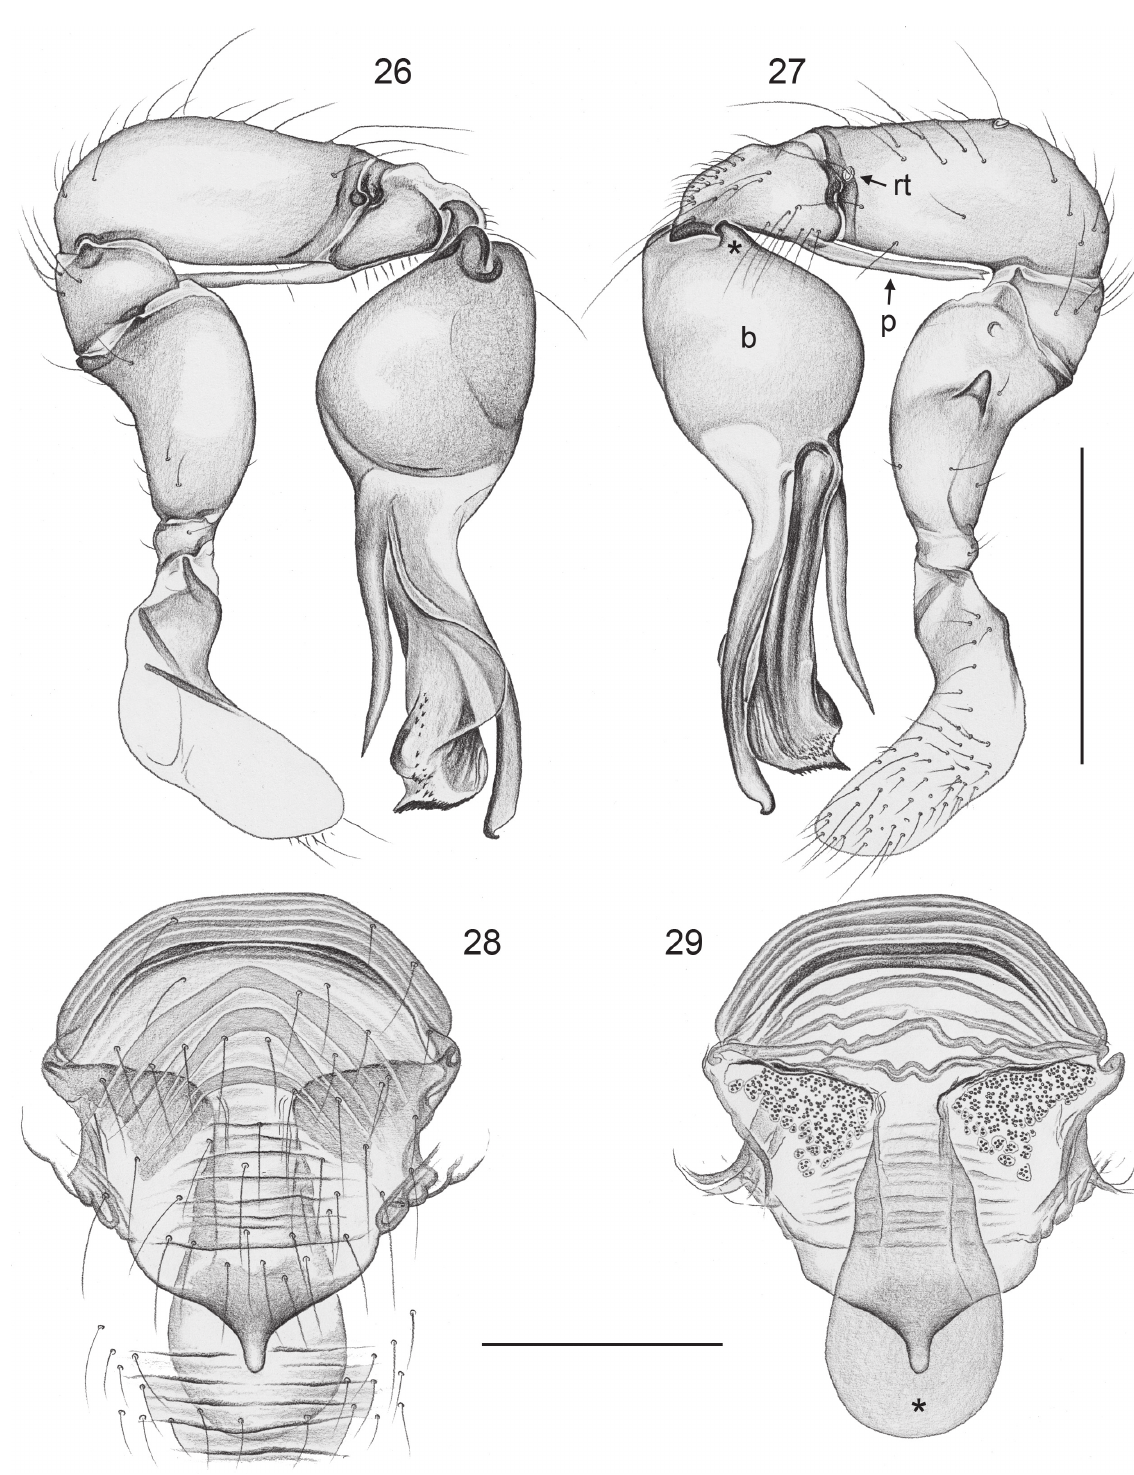
Figs 26–29. Aetana libjo Huber, sp. nov. 26–27 . Left male palp, prolateral and retrolateral views (asterisk: retrolateral process of bulb). 28–29 . Cleared female genitalia, ventral and dorsal views (asterisk: median membranous structure). b = genital bulb; p = procursus; rt = retrolateral trichobothrium. Scale lines: 26–27 = 0.5 mm; 28–29 = 0.3